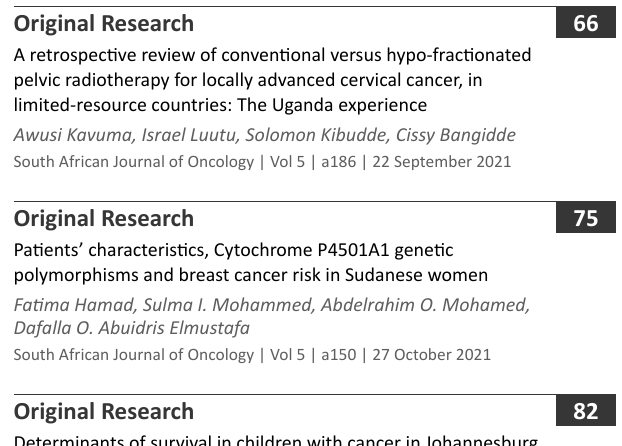
Original Research